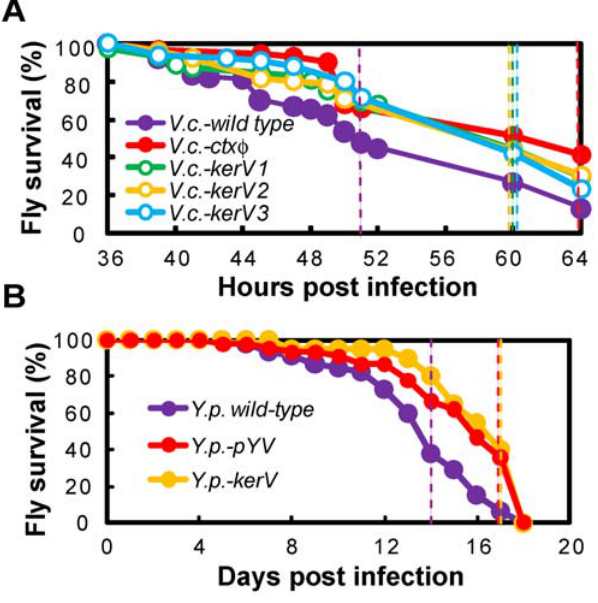
Figure 4. KerV is a conserved virulence determinant in various Proteobacteria. Survival of flies in Drosophila feeding infection assays using wild-type and kerV mutants in V. cholerae (A) and Y. pseudotuberculosis (B) background. Known virulence-compromised strain was used in each assay as negative control and the data are presented in red. Dotted lines represent survival medians for the color- corresponding strains. All mutants were tested for growth in LB broth and none had any notable differences from the parental strain.